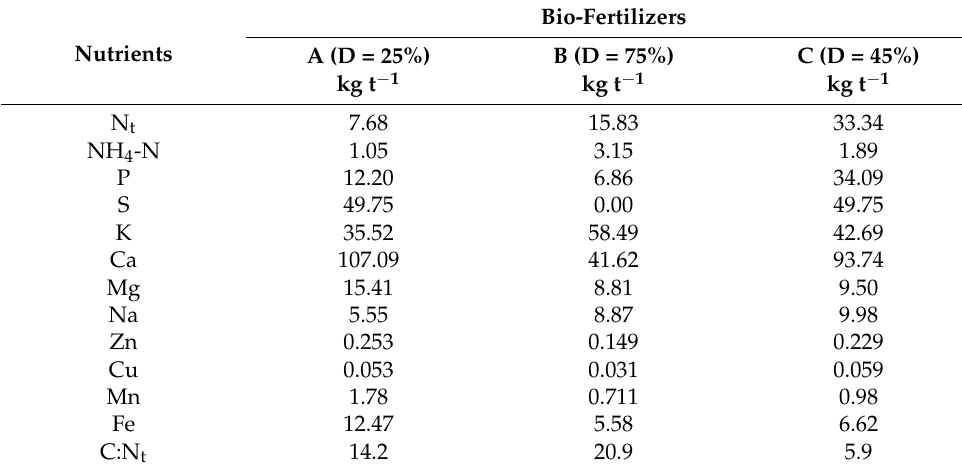
Table 4. Chemical composition and C:N ratio of the tested bio-fertilizers.